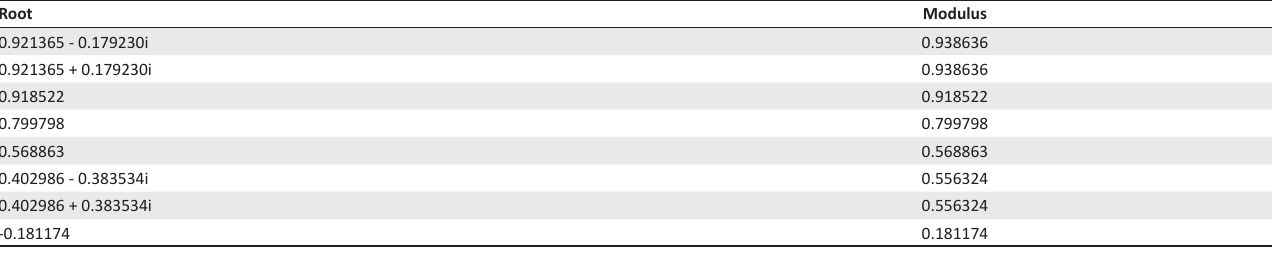
TABLE 8-A1: Autoregressive root test for stability of the vector autoregressive (2) model. Root